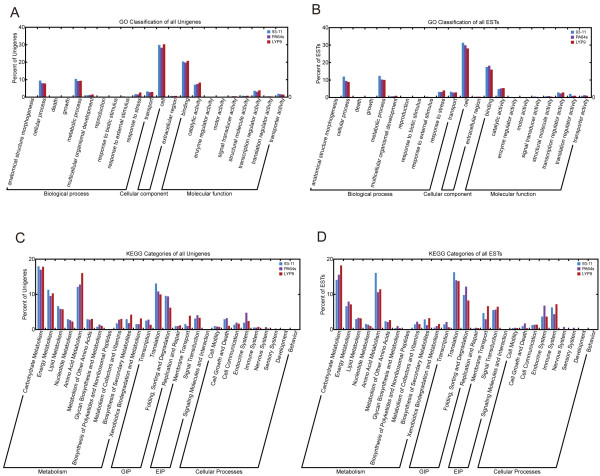
Functional classification of unigenes. Functional classifications are based on GO terms (A, unigenes; B, ESTs) and KEGG categories (C, unigenes; D, ESTs).